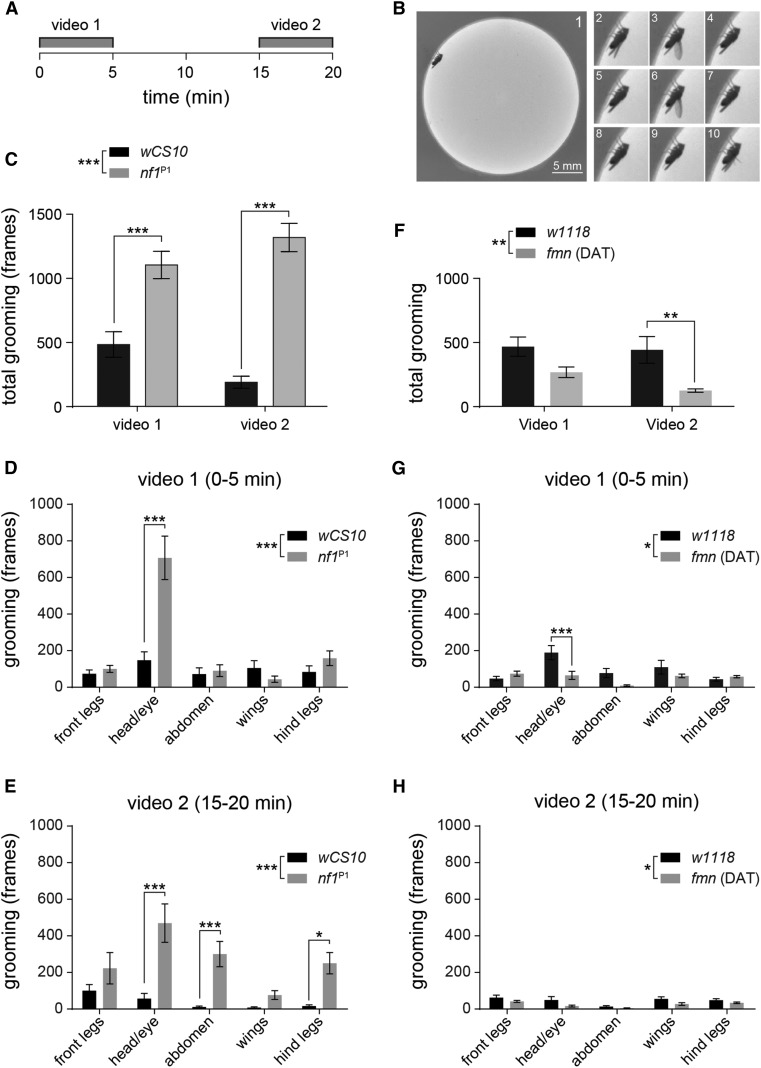
Grooming in nf1P1 and fmn mutants in an open field arena. nf1P1 mutants exhibited increased grooming that was not seen in fmn mutants. Videos were taken at 7.5 frames per sec, and durations are reported in frames. For all panels, the omnibus two-factor ANOVA test result is shown in the legend, and post hoc Sidak’s multiple comparisons are shown between individual bars. * P < 0.05, ** P < 0.01, ** P < 0.01; n = 18 per genotype. (A) Time periods of video recordings. Flies were loaded at time = 0. (B) Individual, sequential frames of a fly exhibiting wing grooming. Frame 1 is cropped slightly from the original video. Frames 2–10 are cropped in the exact same coordinates. (C) Total grooming time of nf1P1 mutants. The same flies are further analyzed in (D) and (E). (D) Grooming time for each body region of nf1P1 mutants for the first 5 min in the open field arena. (E) Grooming time, 15–20 min after transfer to the arena. (F) Total grooming time of fmn dopamine transporter mutants. The same flies are further analyzed in (G) and (H). (G) Grooming time for each body region of fmn mutants for the first 5 min in the open field arena. (H) Grooming time, 15–20 min after transfer to the arena.